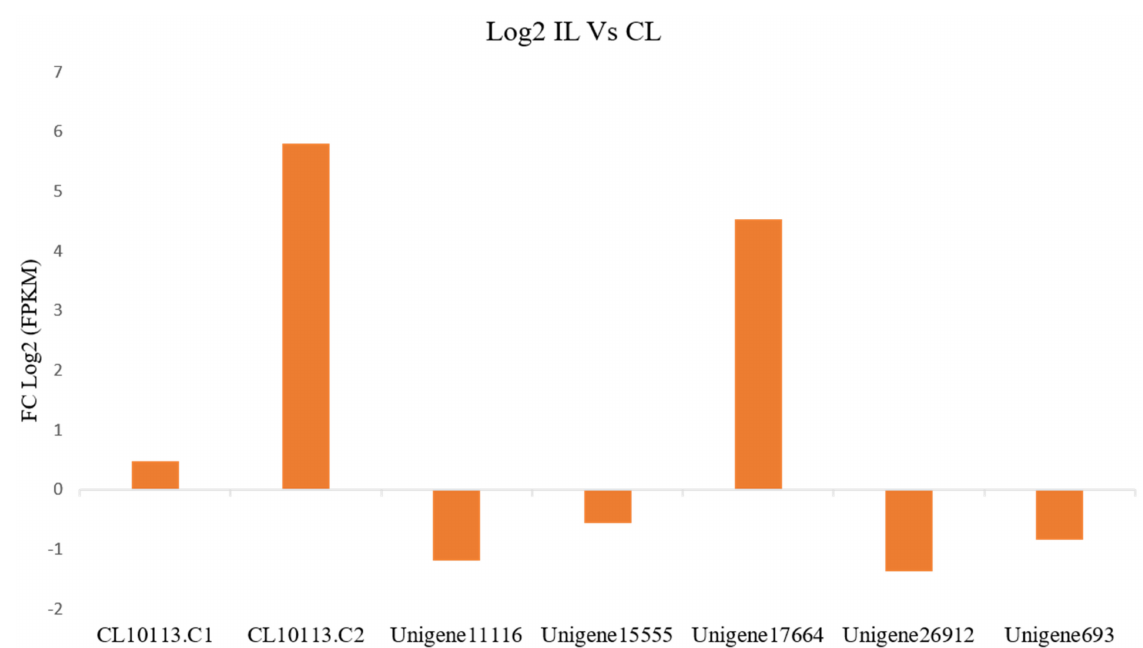
Figure 5. Expression analysis of the PnPR-1 transcripts in Phytophthora capsici -infected P. nigrum using FPKM (fragments per kilobase of transcript per million mapped reads) values. From the left, the PnPR-1 transcripts are designated as CL10113.C1, CL10113.C2, Unigene11116, Unigene15555, Unigene17664, Unigene26912 and Unigene693. Positive and negative numbers on the X -axis indicate the fold changes in the Log 2 gene expression levels.